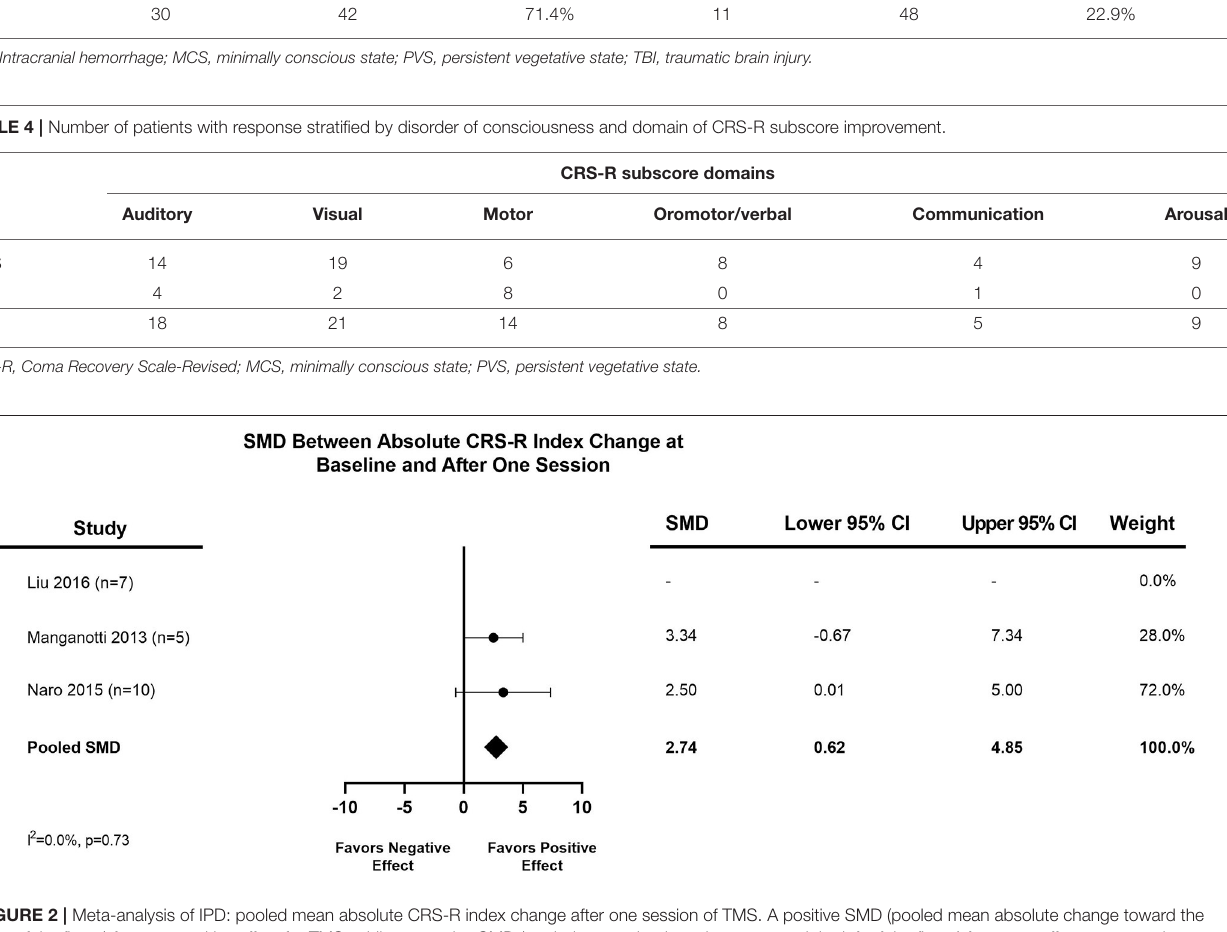
and 7.96 points greater absolute change, respectively ( Table 6